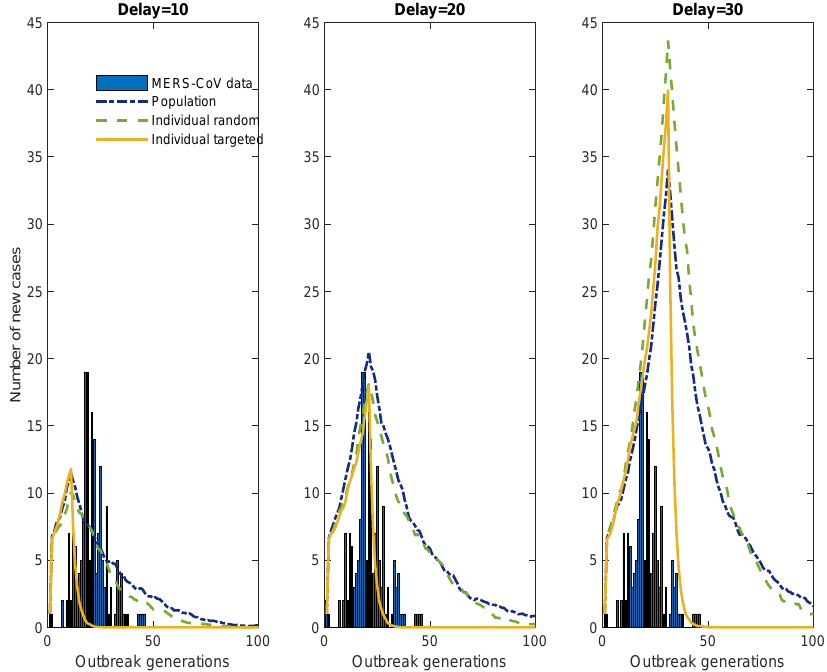
Figure 10. The impact of the timing of starting control measures: the blue bar graph shows the epidemic curve of 2015 MERS-CoV, blue dash-dotted lines denote population control, green dashed lines denote random individual control, and yellow solid lines denote targeting individual